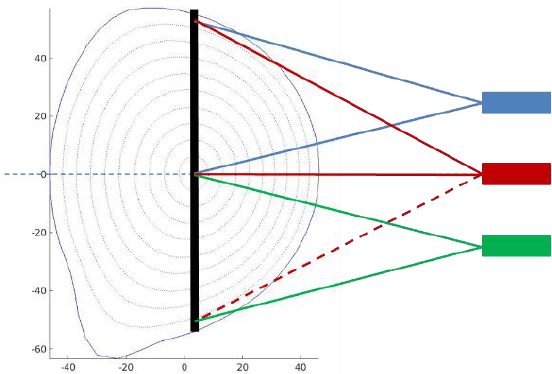
Figure 4: Operational limits determination method for the three steerable mirrors. Only the upper part of the plasma is considered for the middle mirror.